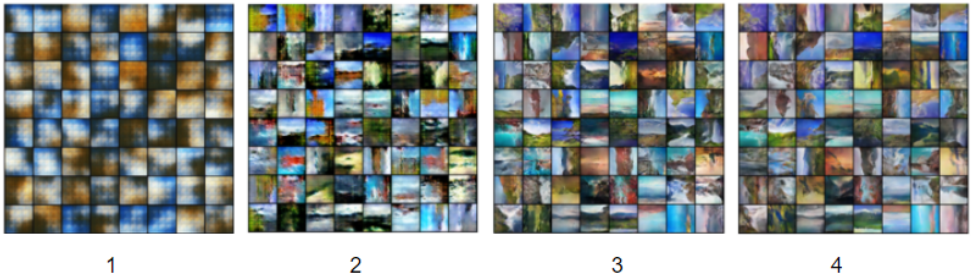
Figure 30. GAN Generator Output 150 LS, 2k